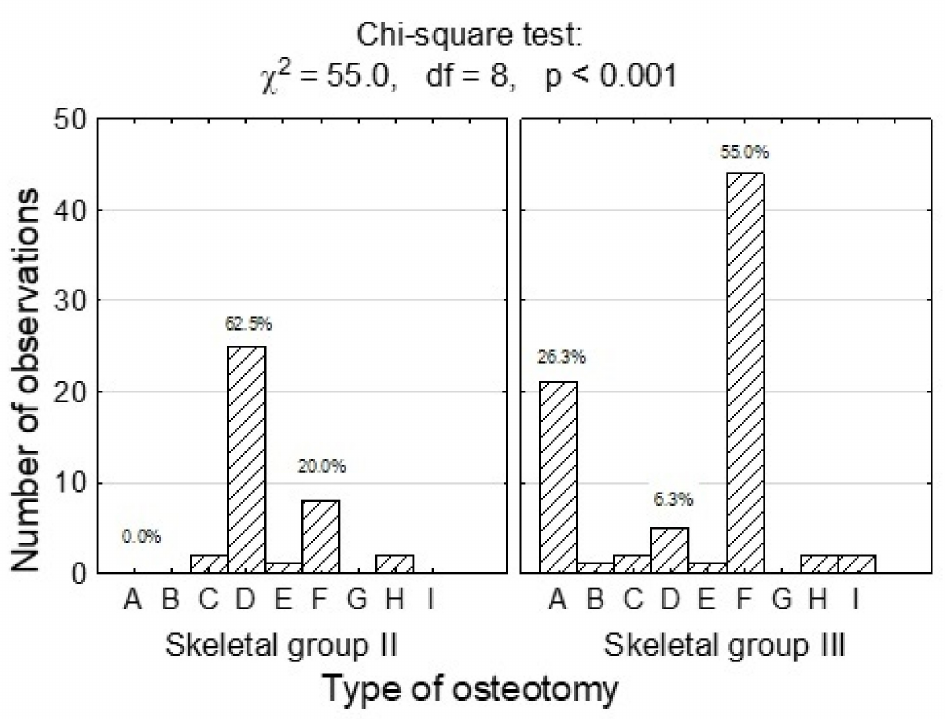
Figure 8. The number (percentage) of patients in the groups with different skeletal classes and types of osteotomy, and the result of the Chi-squared test. A—Le Fort I, B—Le Fort I + segmentation, C—BSSO—Obwegeser–Dal Pont, D—BSSO—Obwegeser–Epker, E—BSSO—Obwegeser–Epker +